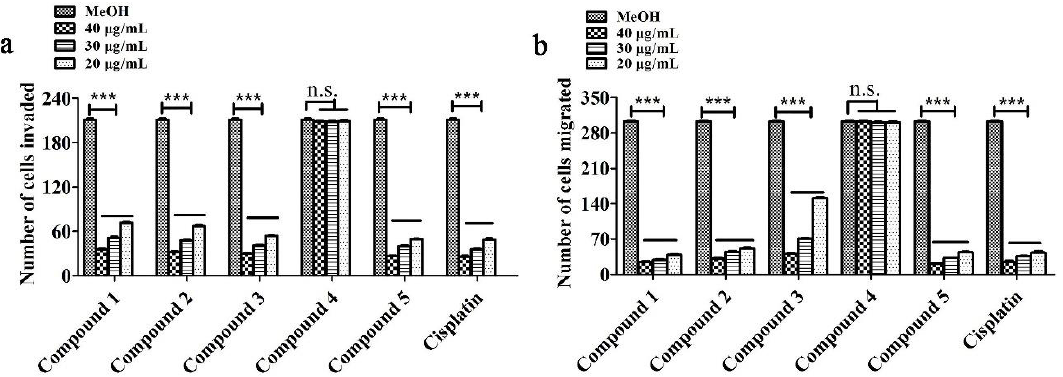
Figure 8. Number of invaded and migrated cells. ( a ) shows the number of cells invaded using different concentrations of the compounds and cisplatin for treatment. ( b ) shows the number of cells migrated using different concentrations of the compounds and cisplatin for treatment. ***: p < 0.001; n.s.: no significance compared to the corresponding control; the p -value is determined by t -test.